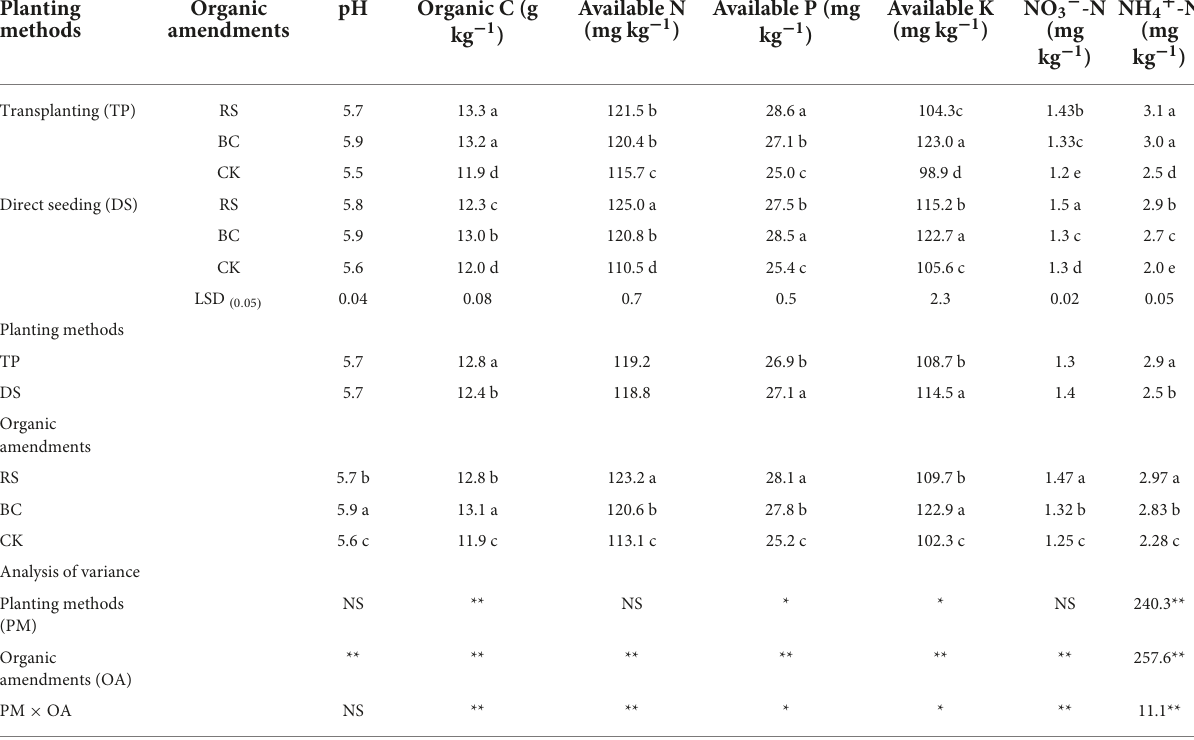
TABLE 3 Soil physicochemical characteristics under different treatments of planting methods and organic amendments. Planting